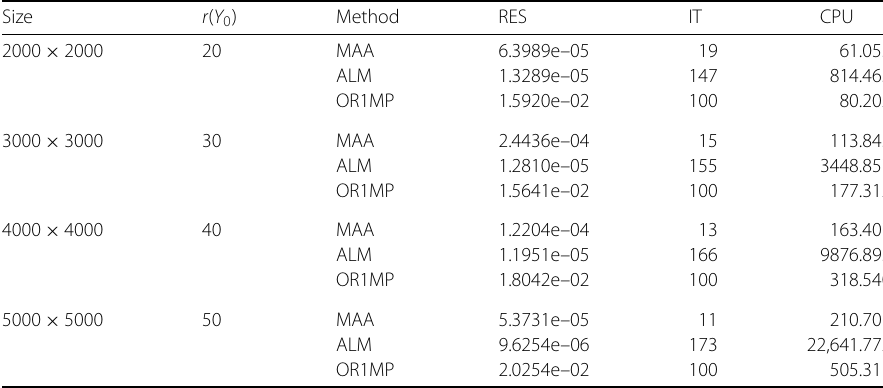
Table 1 Comparison results of three methods for p = 0.1